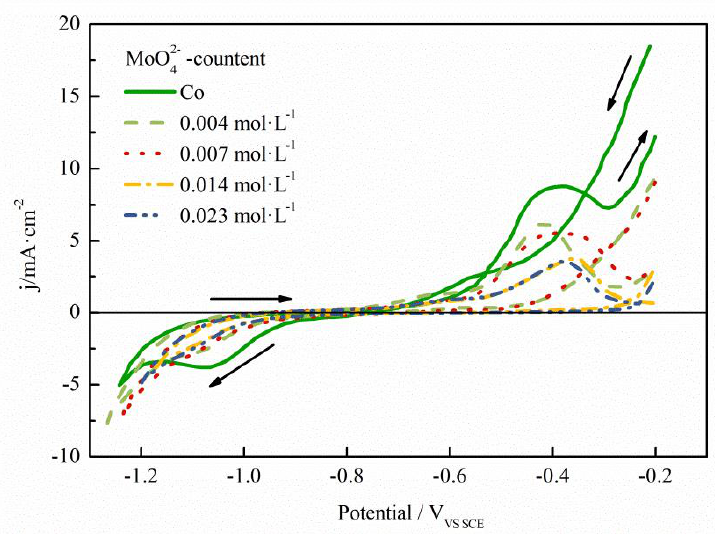
Figure 1. Cyclic voltammograms of Co and Co-Mo electrodeposition in different